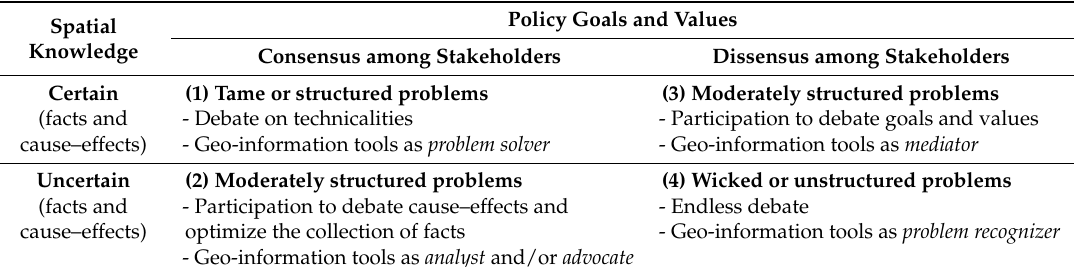
Table 1. Four types of policy problems and related tools (adapted from Hoppe